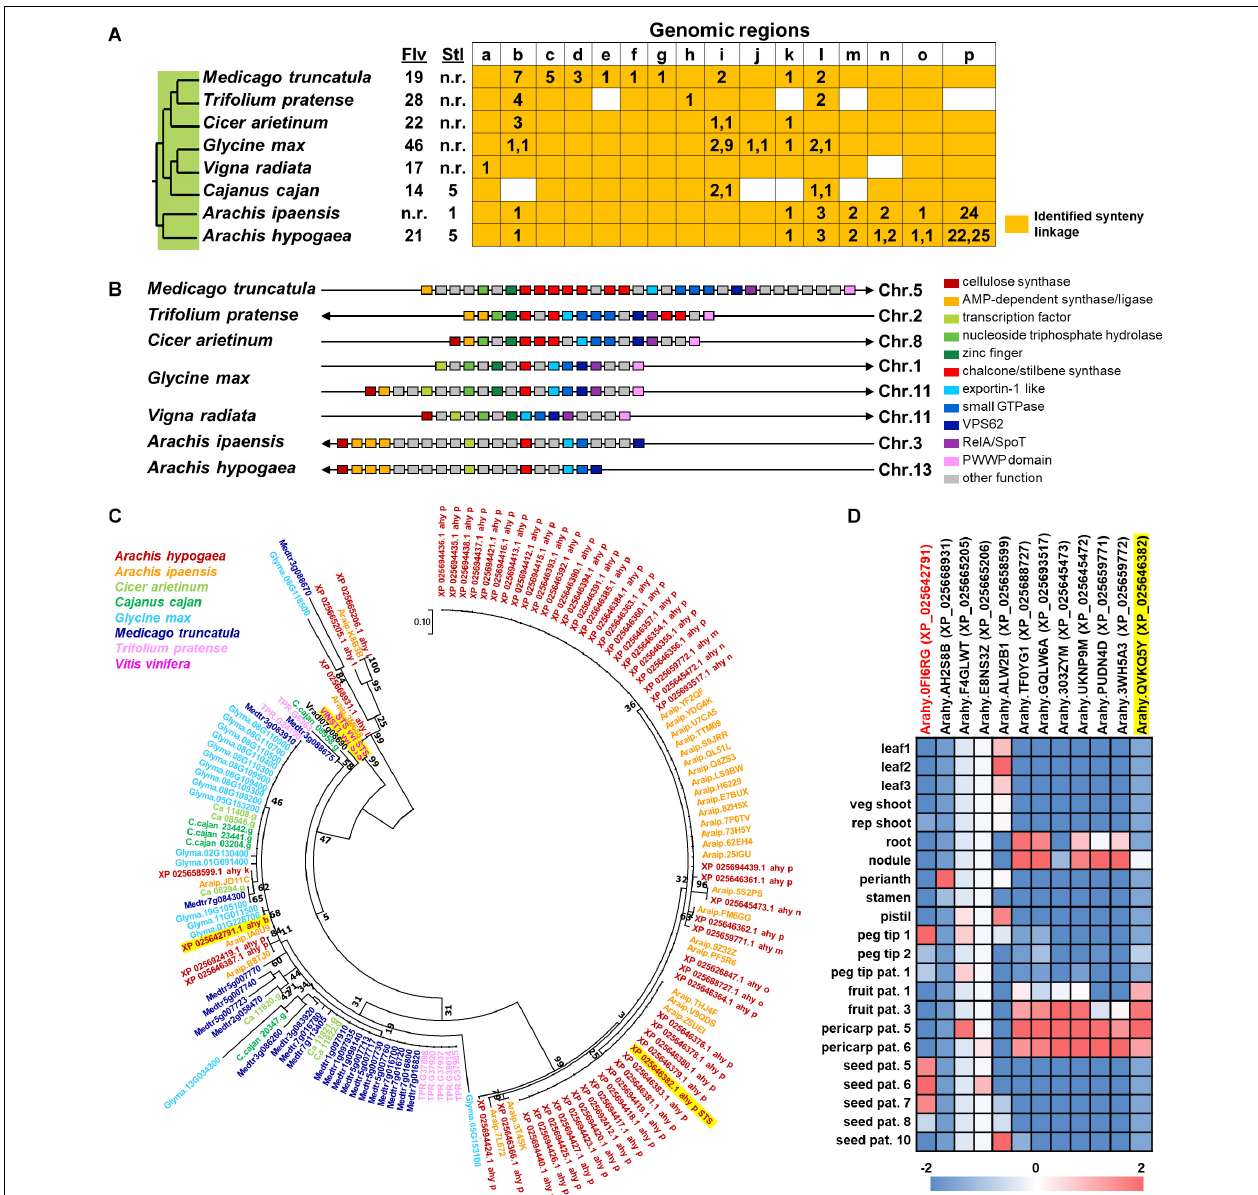
FIGURE 5 | Comparative genomics of CHS and STS in eight legume plant species. (A) Genomic synteny analysis of CHS and STS. Gene lists of six legume plant species were retrieved from Plaza database (Dicot 4.5; http://bioinformatics.psb.ugent.be/plaza/). Almond and peanut genome sequences were obtained from the NCBI database. Numbers in each region indicate the number of tandem duplicated genes. Numbers in each region indicate the number of tandem duplicated genes and intra synteny genes. Abbreviations used: Flv, flavonoids; and Stl, stilbenoids. (B) Genomic structure of synteny regions b presented in Figure 1A . (C) Phylogenetic relationship of CHS and STS located in genome synteny analysis of thirteen plant species. Amino acid sequences were attained from the Plaza database (Dicot 4.5; http://bioinformatics.psb.ugent.be/plaza/) coupled with the NCBI database. The phylogenetic trees were constructed with aligned protein sequences by MEGA7 (Kumar et al., 2016) using the neighbor-joining method with the following parameters: Poisson correction, complete deletion, and bootstrap (1000 replicates, random seed). The protein sequences were aligned by MUSCLE implemented in MEGA. Values on the branches indicate bootstrap support in percentages. The tree with the highest log likelihood (–1287.37) is shown. Colors of circle indicate plant species. (D) Gene expression profile of peanut tissues. Each gene is connected with the syntenic region. Gene expression data; part and stage of peanuts are described by previous work of Clevenger and colleagues (Clevenger et al.,